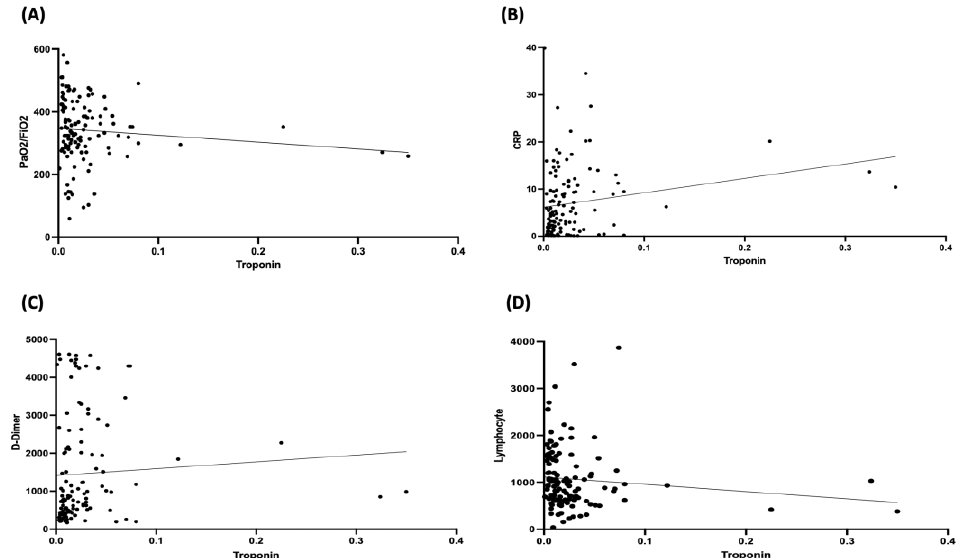
Figure 2. Correlation analyses between troponin values and PaO 2 /FiO 2 (Panel A ), CRP (Panel B ), D-dimer (Panel C ), and lymphocyte count (Panel D ) at hospital admission. CRP, C-reactive protein (expressed as mg/dL). D-dimer, troponin, and lymphocyte count are expressed as ng/mL, μg/L, and lymphocytes/μL, respectively.